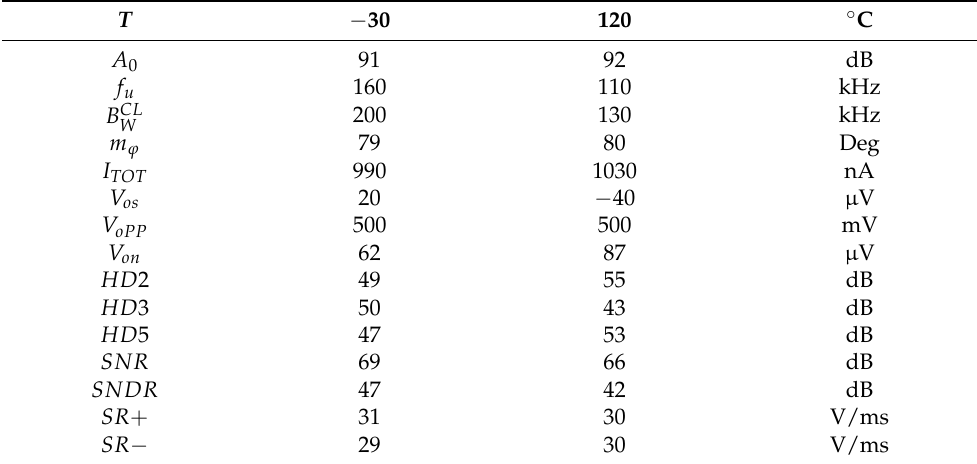
Table 3. Temperature variations in the − 30 ◦ C to 120 ◦ C range.